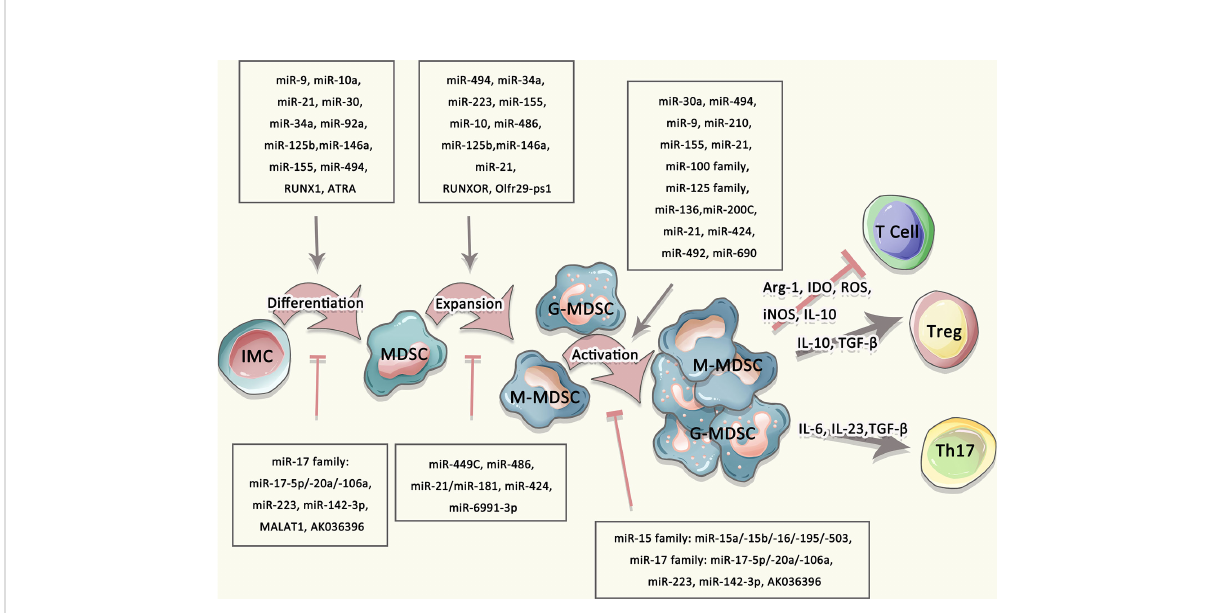
FIGURE 2 Multiple agents regulated the differentiation, expansion, and activation of MDSCs. The differentiation and expansion of MDSCs were regulated by multiple mediators, such as IL-10, IL-23, TGF- b as well as miRNA,